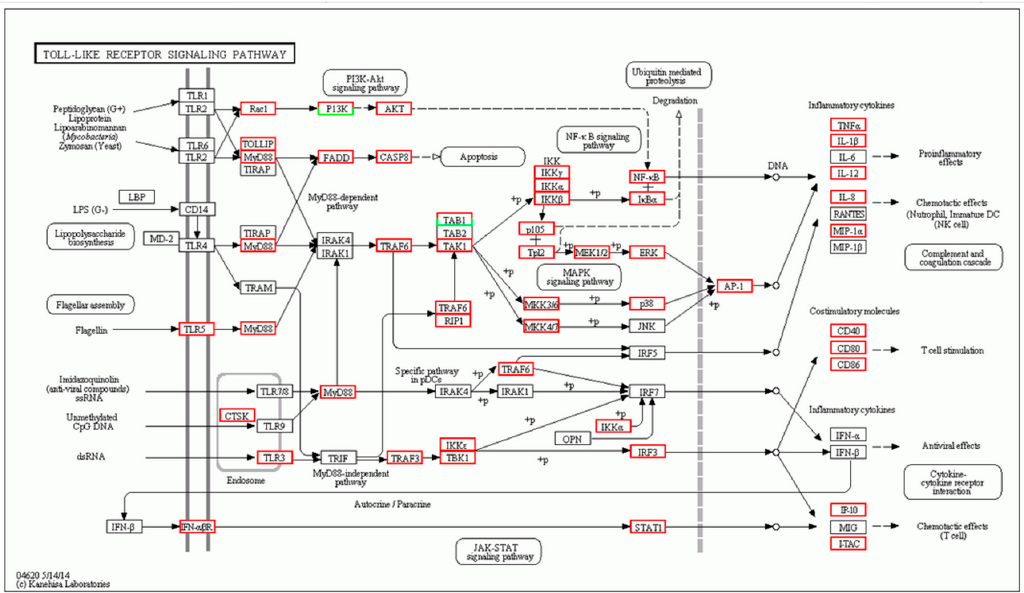
Figure 6. Toll-like receptor signaling mapping in muscle by KEGG. Red boxes indicate significantly differentially up-regulated expression and white boxes indicate unchanged expression in the transcriptomic profile.